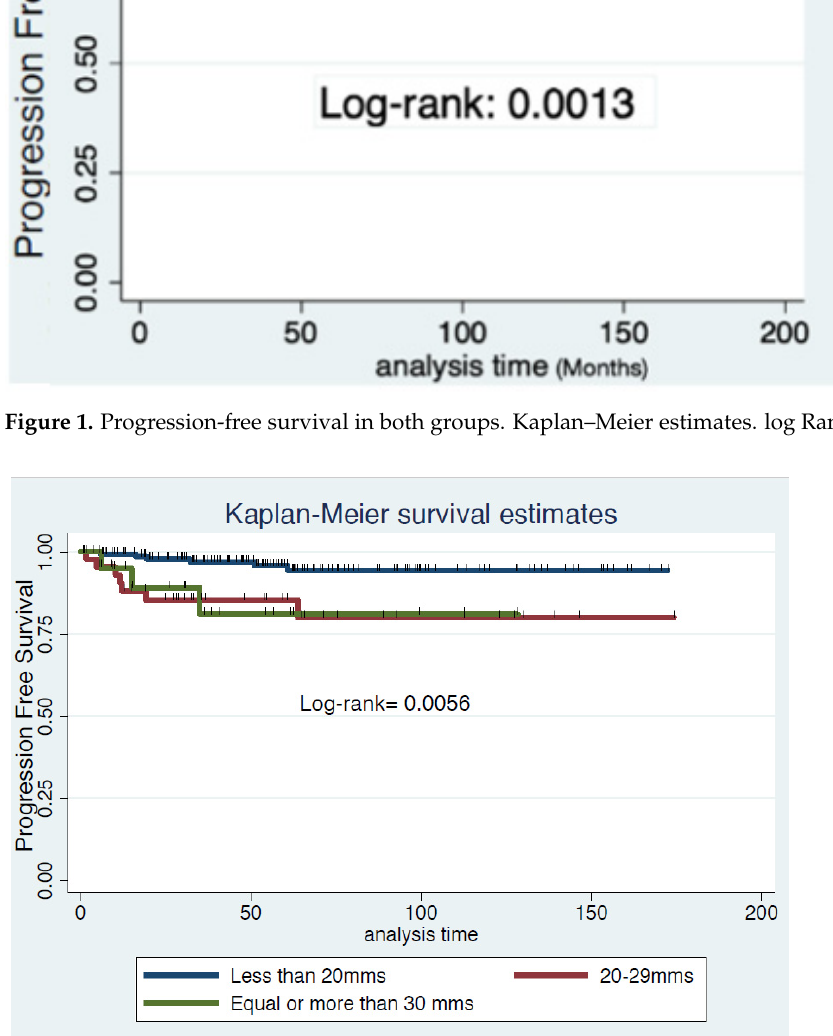
Figure 2. Progression-free survival in three groups. Kaplan–Meier estimates. log Rank: 0.006.